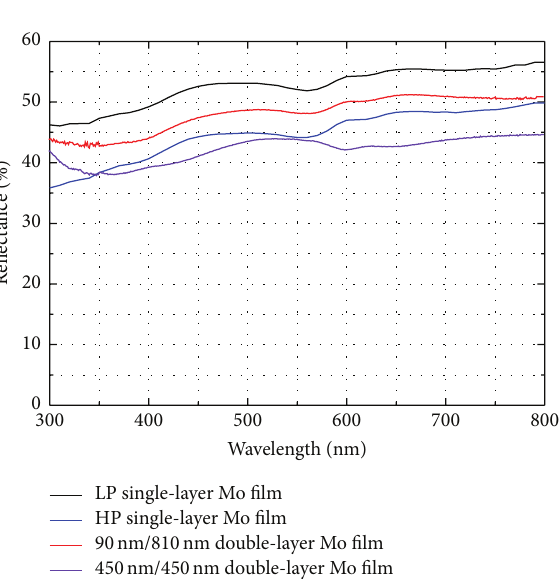
Figure 7: Measured optical reflectance of single-layer (LP and HP deposited) Mo films and bilayer Mo films (with 90 nm and 450 nm thick HP deposited bottom